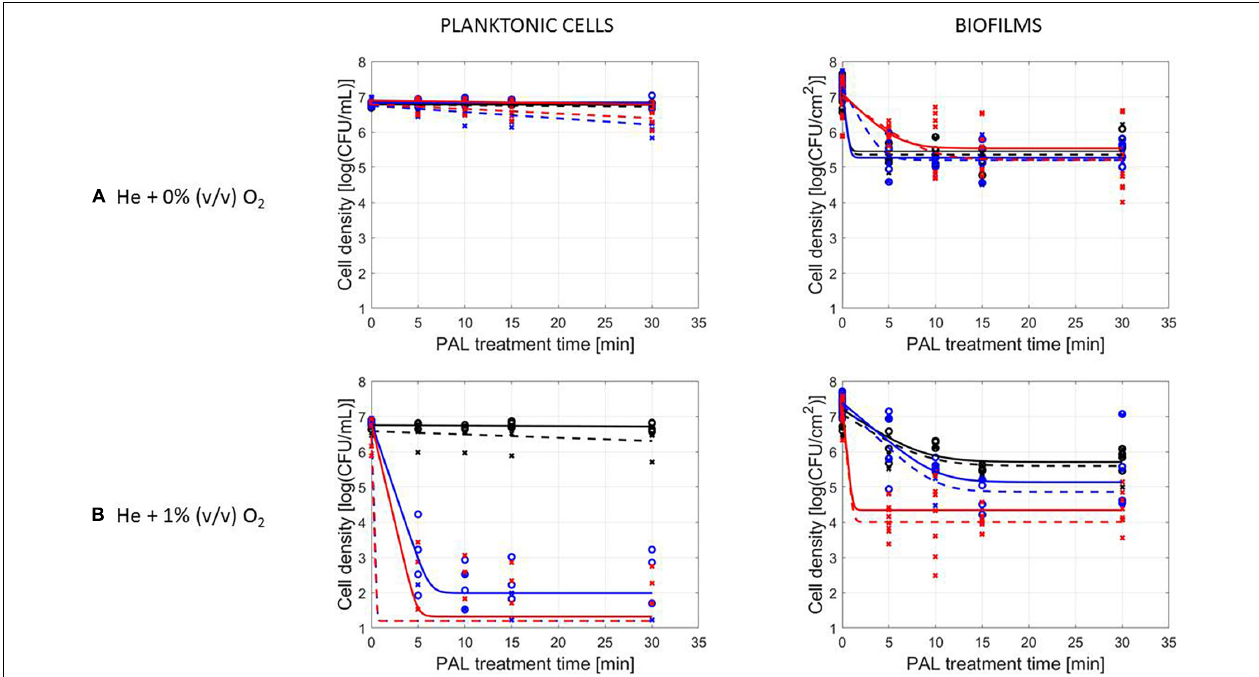
FIGURE 2 | Survival curves of L. monocytogenes planktonic cells and biofilms after plasma activated liquid treatment. Plasma activated liquids were created using two different cold atmospheric plasma gas compositions (A) He + 0% (v/v) O 2 or (B) He + 1% (v/v) O 2 , and three different generation times (10, 20, and 30 min). Experimental data (symbols) and global fit (line) of Geeraerd et al. (2000) model: total viable population (o, solid line) and uninjured viable population (x, dashed line).